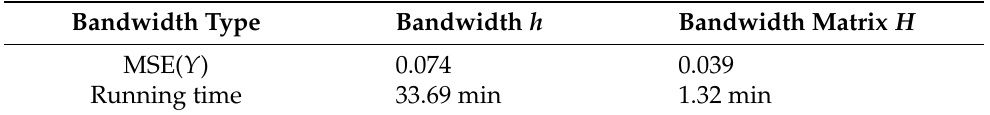
Table 2. Selected bandwidth and results of MSE.